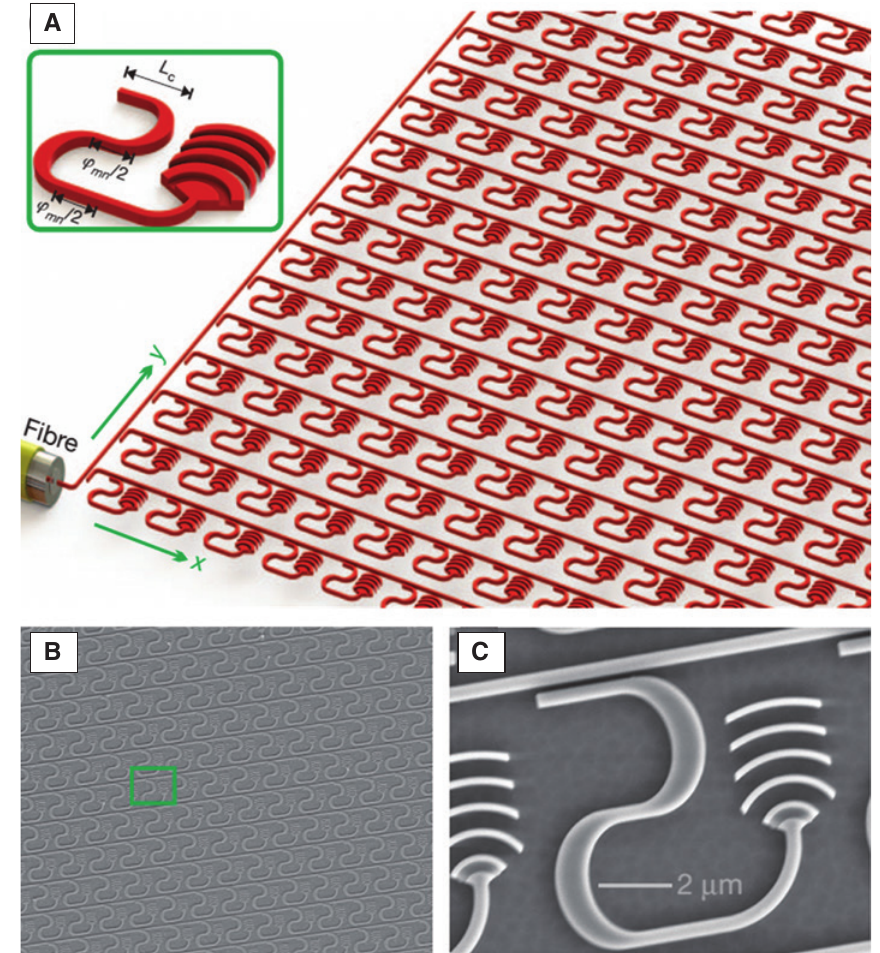
Figure 5: Silicon photonic two-dimensional optical phased array. (A) Schematic illustration of a two-dimensional emitter array. Laser light is coupled into the input waveguide on the chip and distributed equally over the array. Grating couplers act as emitters by coupling the laser light out of plane. A scanning-electron microscope picture of the array is shown in (B) and a close-up of the grating emitter is shown in (C). Reprinted by permission from Macmillan Publishers Ltd. Nature [19], copyright